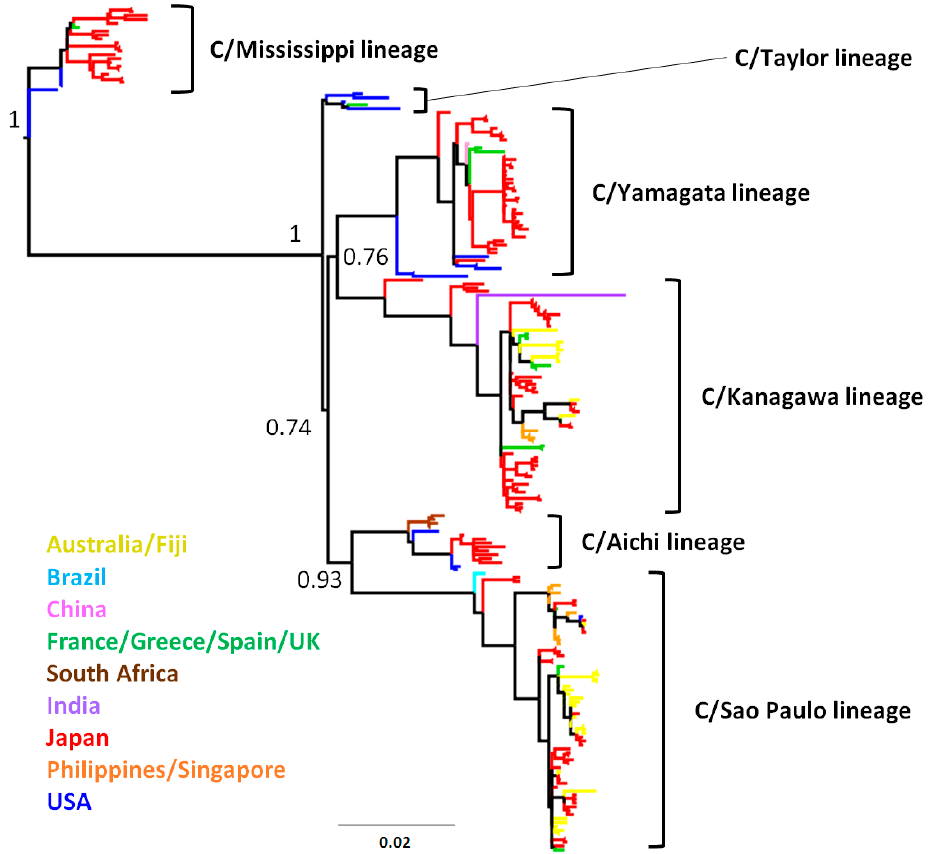
Figure 1. Phylogenetic tree for the hemagglutinin-esterase (HE) gene. The evolutionary history was inferred using the PhyML method for the HE gene (1917 positions) of influenza C viruses. Genetic lineages were defined by our previous study [18]. Approximate likelihood ratio test (aLRT) branch supports at the node to define each lineage are shown. Branches are colored by country.